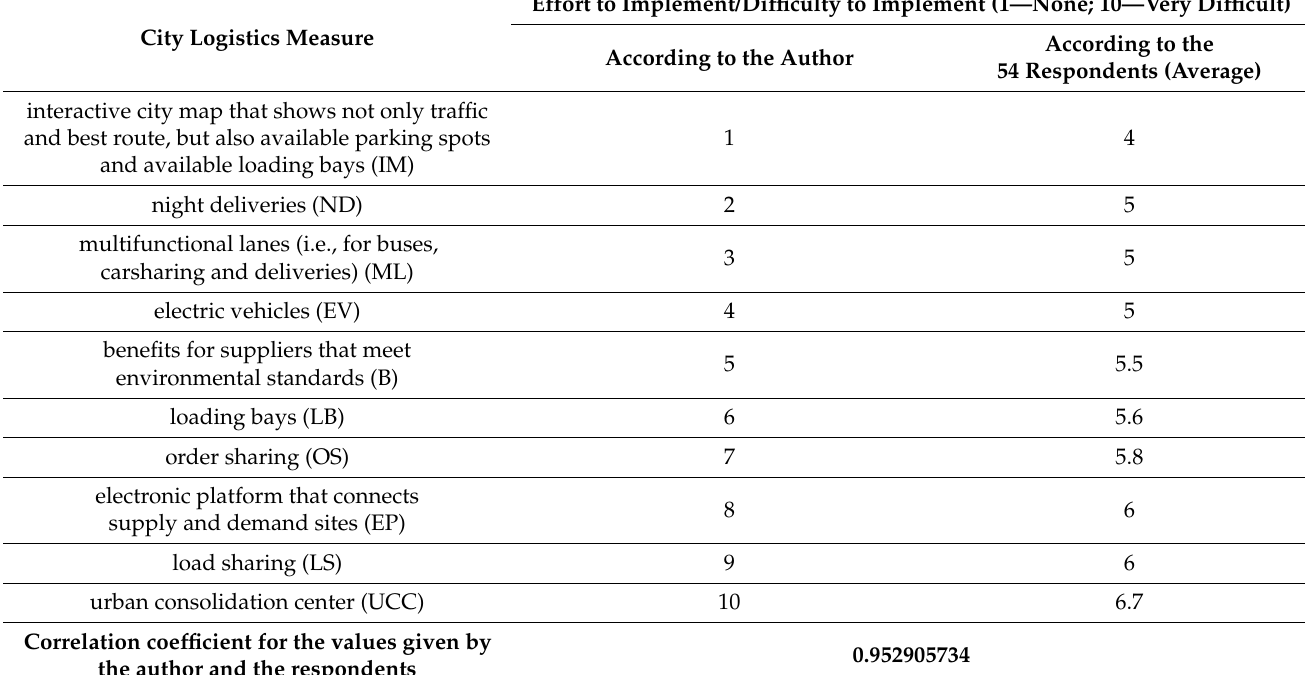
Table 4. Level of difficulty in implementing the measures according to the author and the